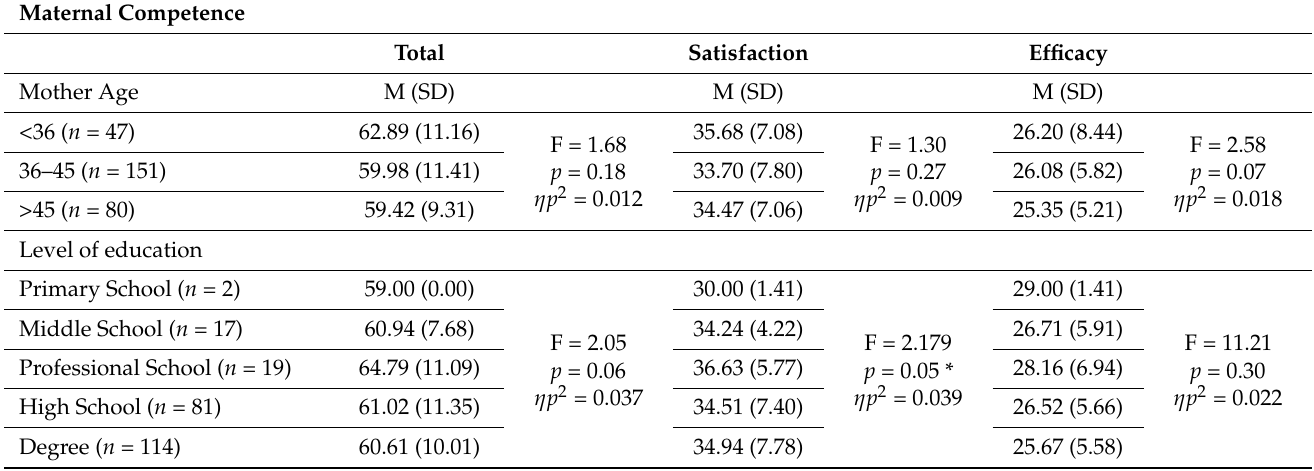
Table 1. Means, standard deviations, and ANOVAs of the dependent variables (mother age, level of education, work regimen during the first Lockdown for COVID-19, child age, child sex and child atypical development) for the dependent variable maternal